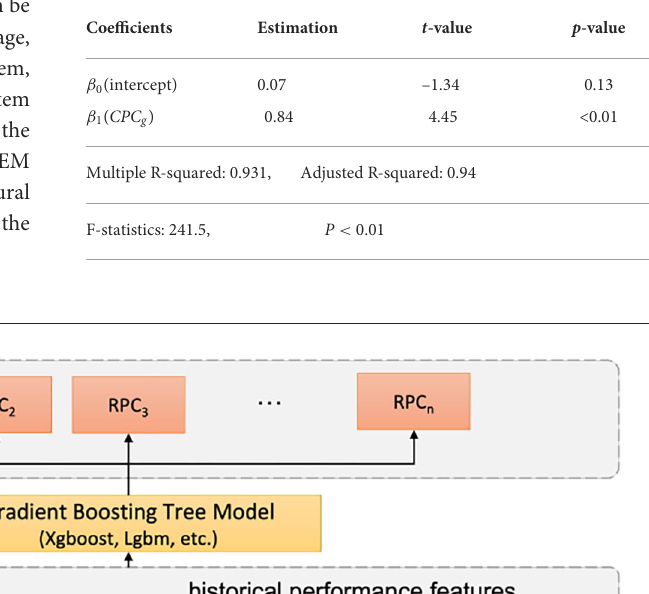
TABLE 2 Linear regression: CPC g ∼ β 0 + β 1 · b g .